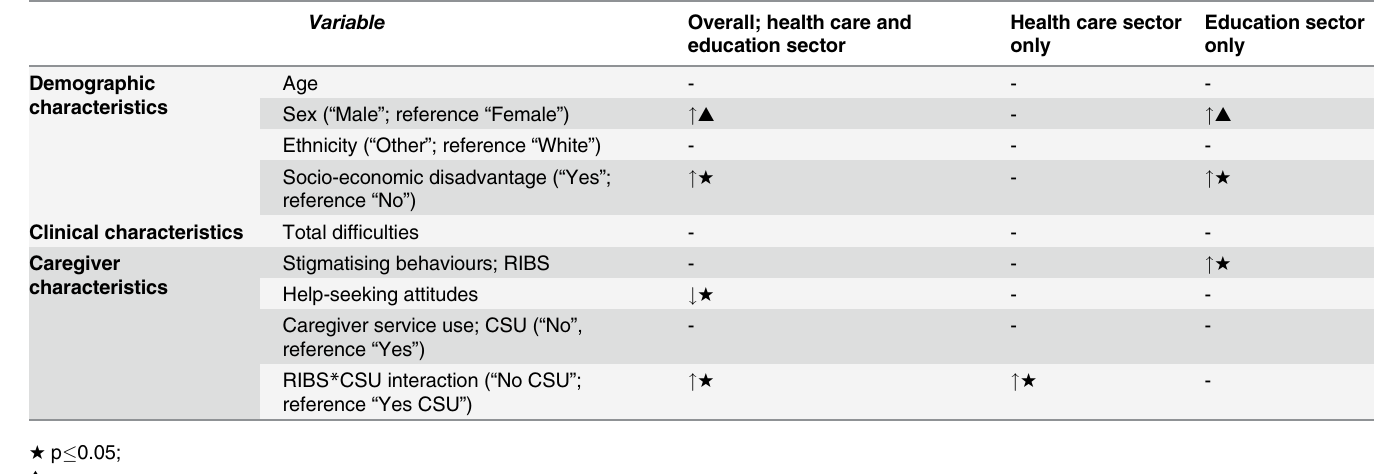
Table 6. Overview of the results of the final adjusted models for each of the three service use outcomes assessed in this study.